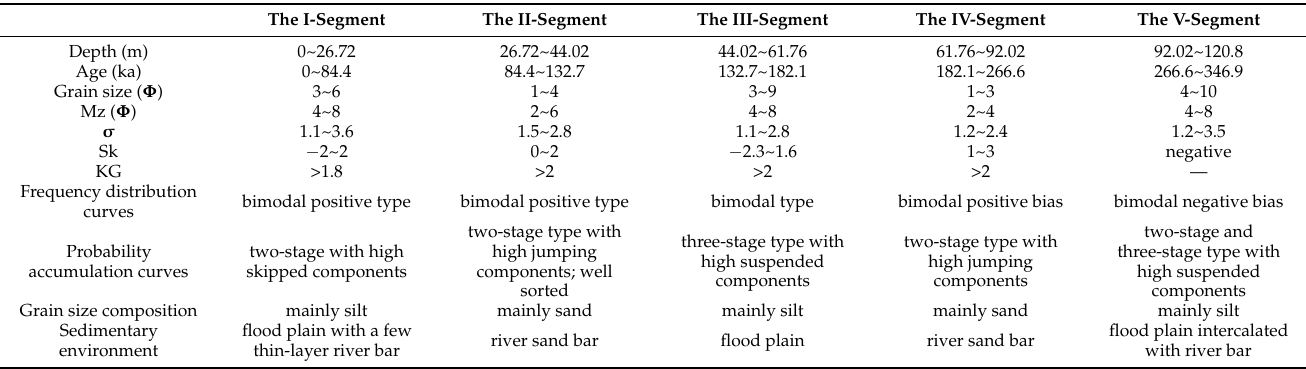
Table 2. Five distinct sedimentary processes of the SHBZK-1 core in north Hebei